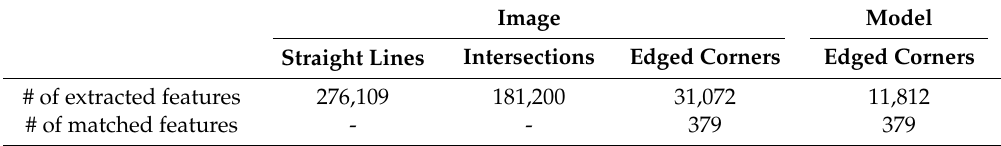
Table 8. Quantitative assessment with check points (the Vaihingen dataset, unit: pixel). With Error-Contained Initial